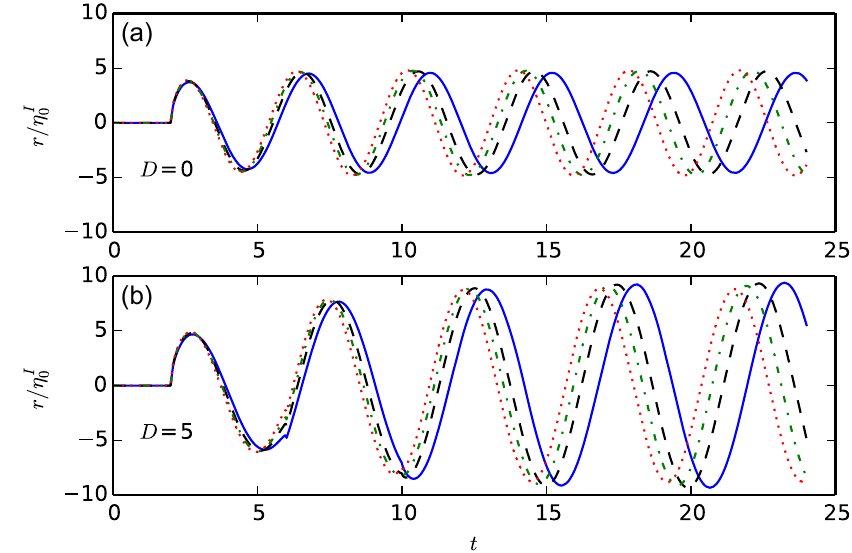
Figure 4. The run-up normalised to the amplitude of the incident wave for Model-1. In panel (a) , the frequency of the incident wave is (cid:60) ω 1 (D = 0 ) for the blue continuous curve, 1 . 05 (cid:60) ω 1 (D = 0 ) for black dashed curve, 1 . 075 (cid:60) ω 1 (D = 0 ) for the green dashed–dotted curve and 1 . 1 (cid:60) ω 1 (D = 0 ) for the red dotted curve. In panel (b) the frequencies (cid:60) ω 1 (D = 0 ) , 1 . 05 (cid:60) ω 1 (D = 0 ) , 1 . 075 (cid:60) ω 1 (D = 0 ) and 1 . 1 (cid:60) ω 1 (D = 0 ) have been replaced by (cid:60) ω 1 (D = 5 ) , 1 . 05 (cid:60) ω 1 (D = 5 ) , 1 . 075 (cid:60) ω 1 (D = 5 ) and 1 . 1 (cid:60) ω 1 (D = 5 ) respectively. Depth dis- continuity D is 0 in panel (a) and 5 in panel (b) . Refer to Table 1 for the values of ω 1 . All curves are obtained using series of residues. Note that in the bottom figure the wave arrives at the shore at t = 2 and the first reflection from the toe of the slope reaches the shore at t = 6, for which the continuous plot includes a slight glitch. In the main text we elaborate on this glitch.